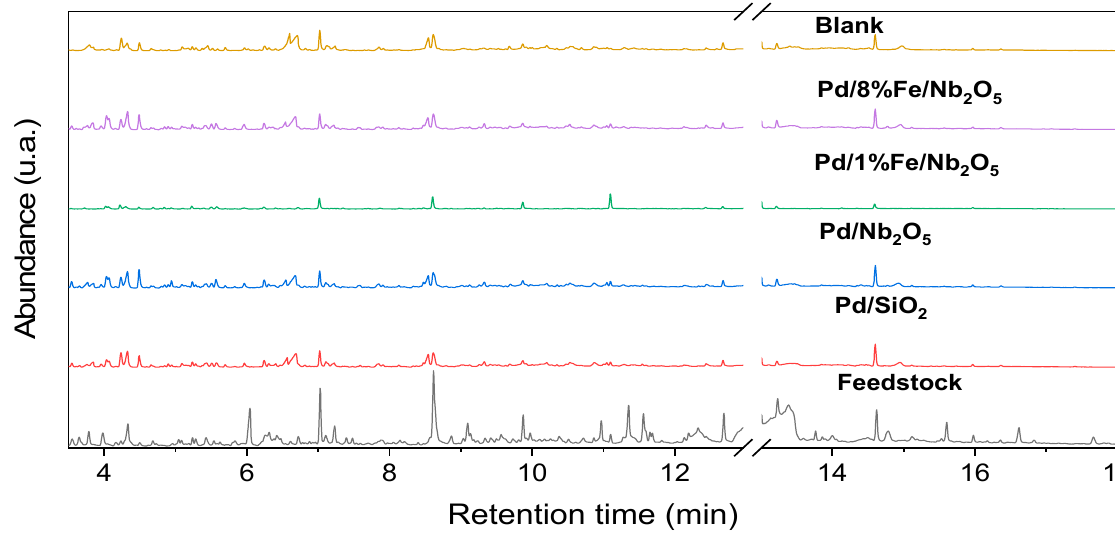
Figure 10. GC-MS: Aqueous phases and feedstock.